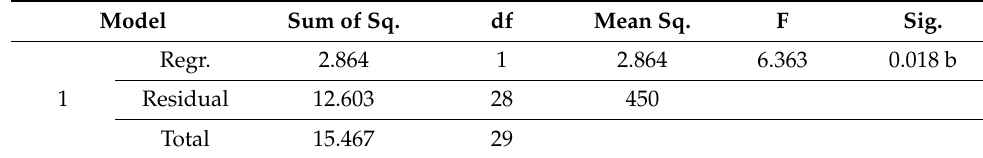
Table 5. E-court use and e-court user satisfaction. Model